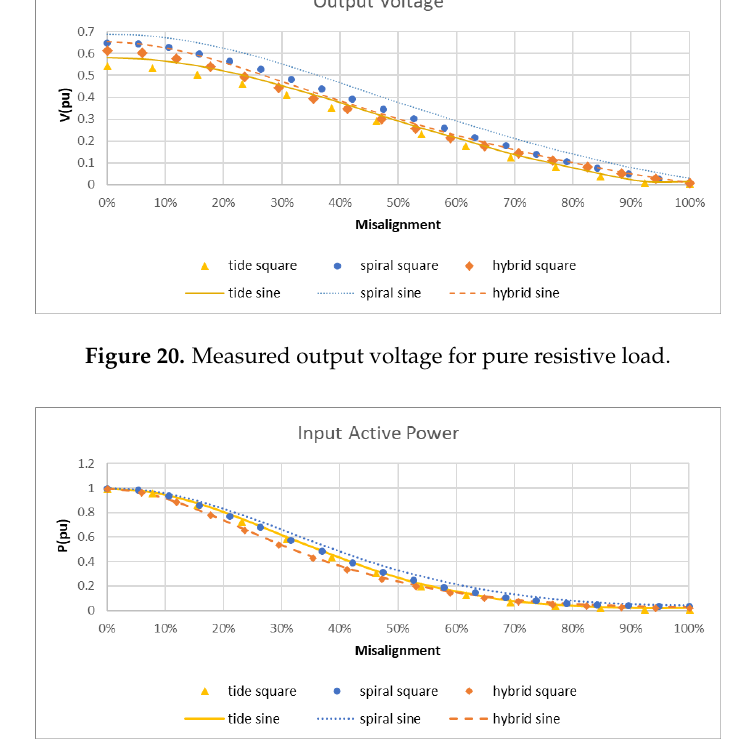
Figure 21. Measured input active power for pure resistive load.